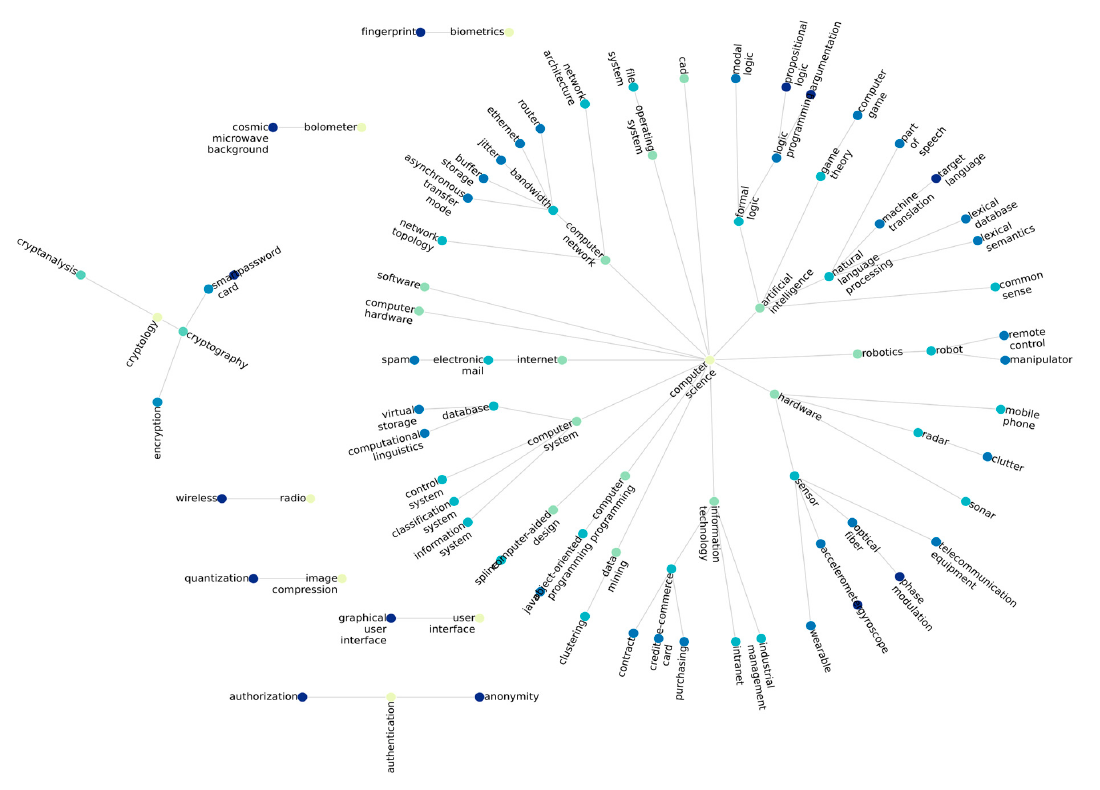
Figure 7. CSO Hierarchy: the illustration represents the connections between the different keywords present in CSO.